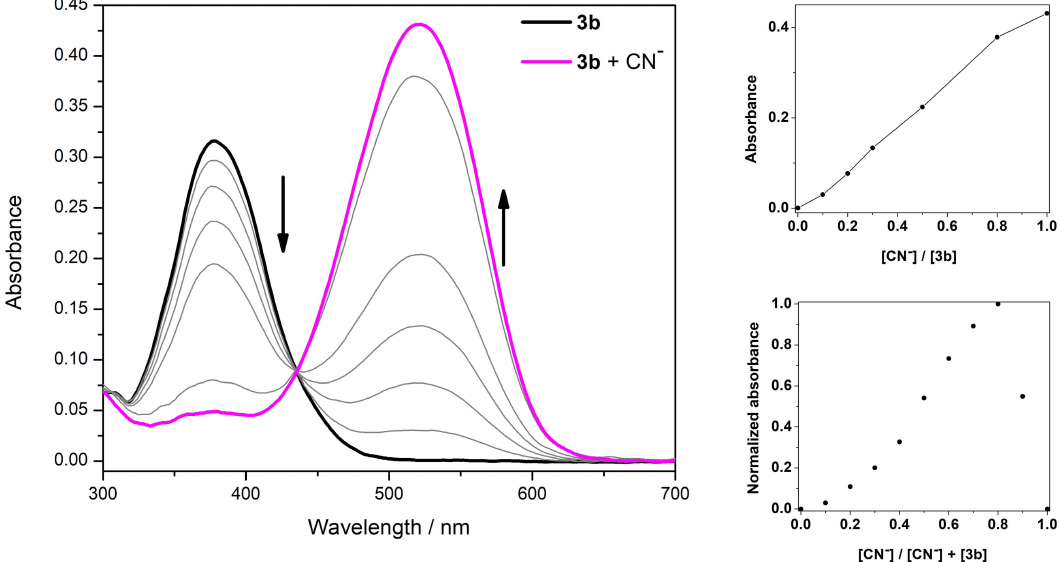
Figure 2. Photophysical interaction between compound 3b and CN − (1 equiv. of CN − required for maximum absorbance). Left —spectrophotometric titration of compound 3b with CN − ; Top right —absorbance at 520 nm as a function of added ion equiv.; Bottom right —Job’s plot for the interaction (stoichiometry 3b 1:3 CN − ).